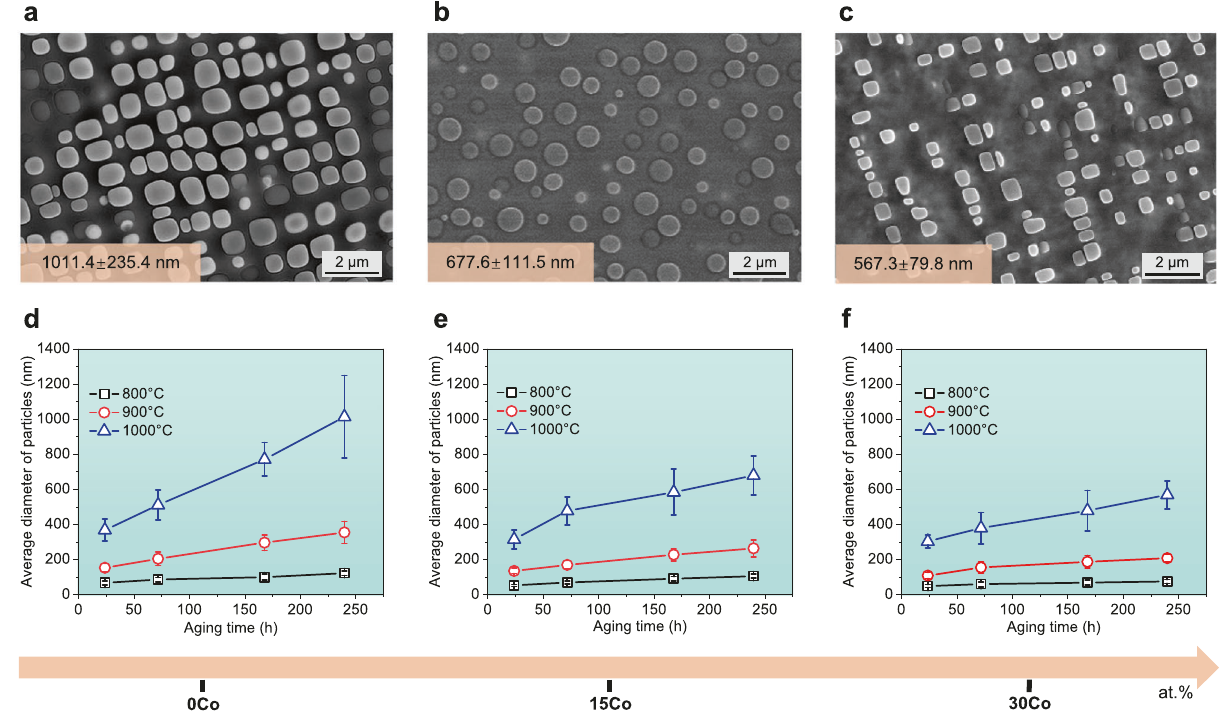
Fig. 1 | Enhanced thermal stability in the studied CCAs with the addition of Co element (0,15,and30at.%).a – c TypicalSEMmicrographsof nanoparticlesinthe three CCAs aged at 1000°C for 240h, and their average diameters are separately